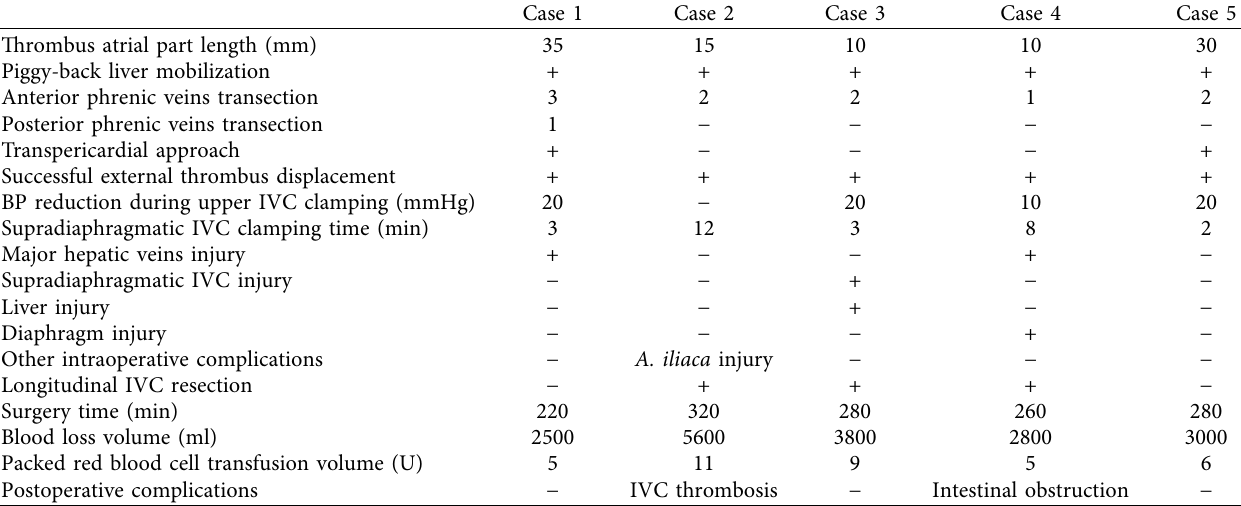
Table 2: Characteristics of surgical procedures and